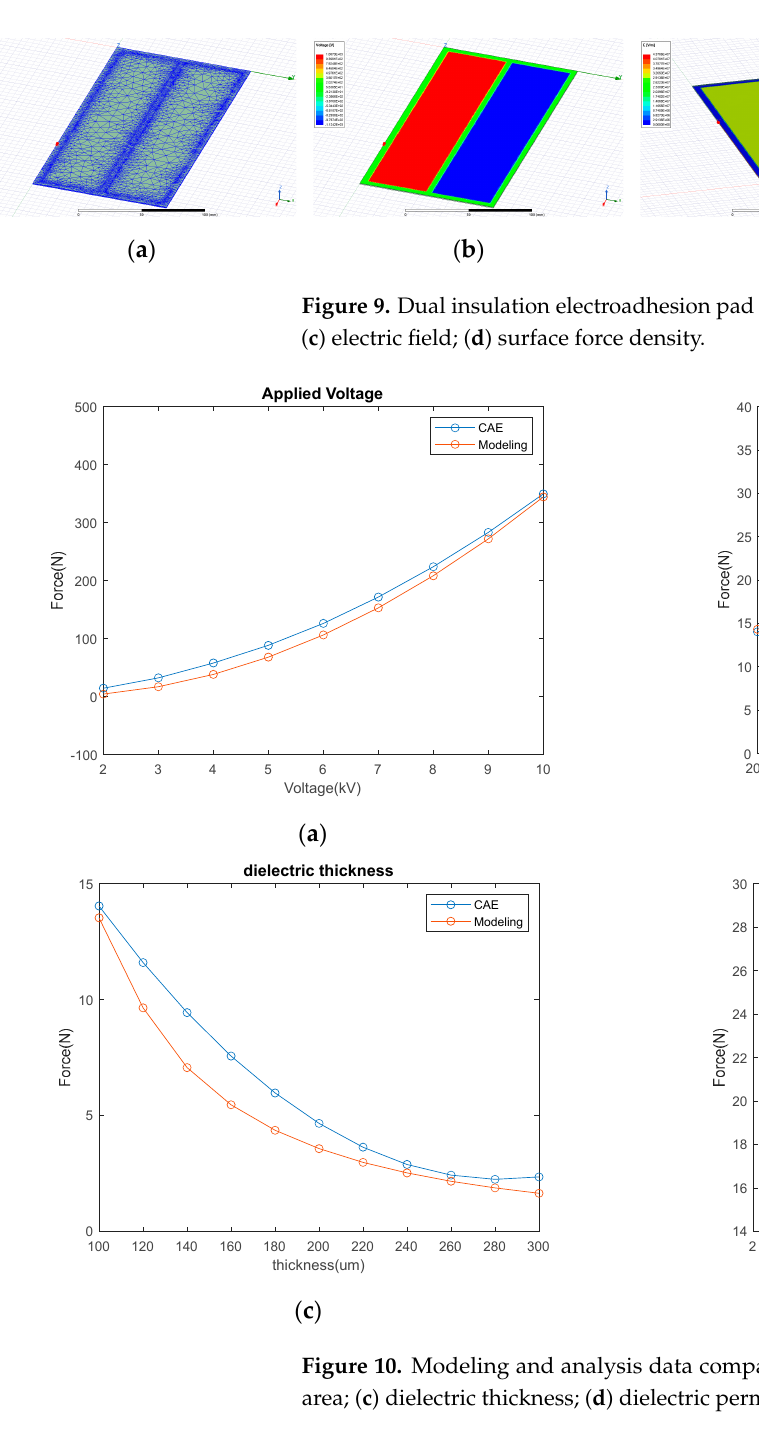
Figure 9. Dual insulation electroadhesion pad FEM analysis result: ( a ) meshing; ( b ) applied voltage; ( c ) electric field; ( d ) surface force density.